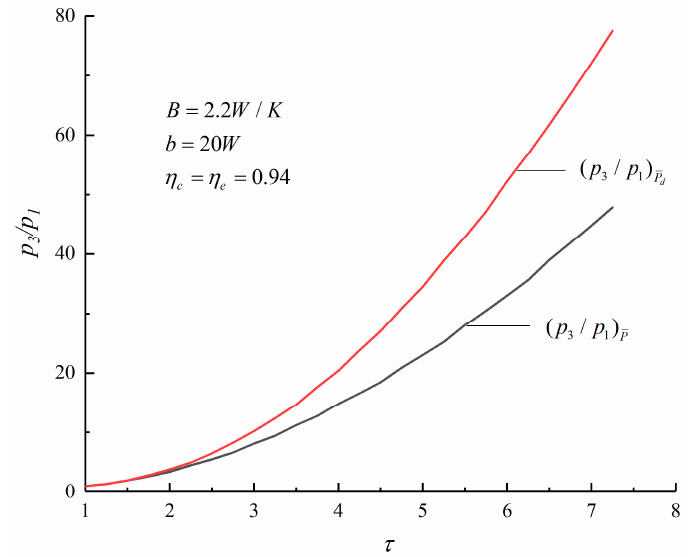
Figure 7. The curves of